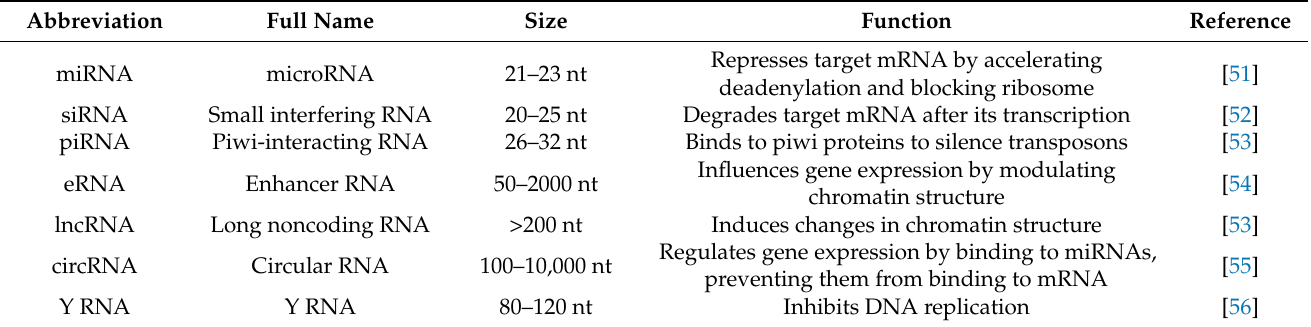
Table 1. Regulatory ncRNAs and their targets. Adapted from Zhang et al.